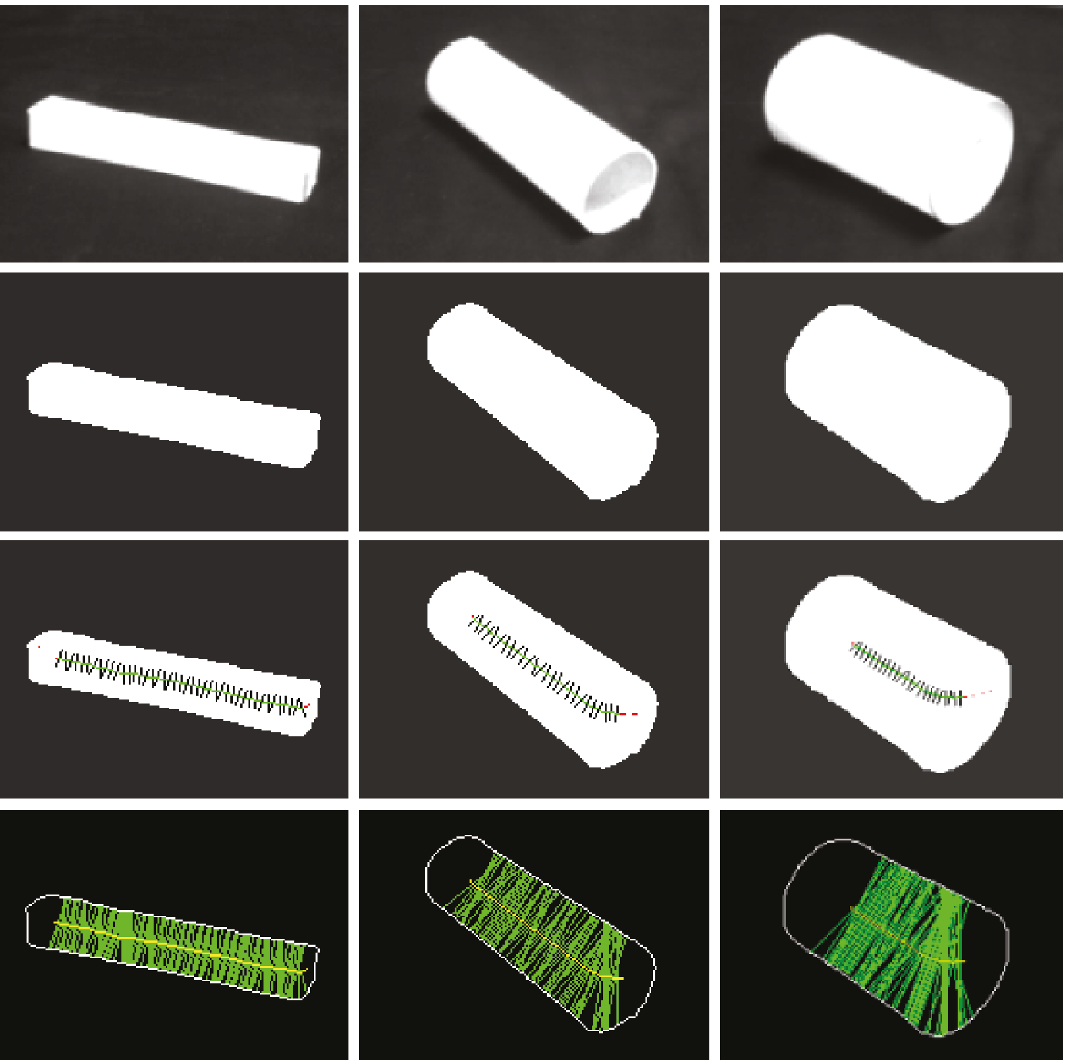
Figure 6: Detection test with simple images. The first row contains the original images. In the second row, the results of a segmentation stage are depicted. The third row contains the results of the curvilinear properties evaluation algorithm. The points of the skeletons inside the region of interest have been drawn; the green pixels represent the parts of the skeleton with a positive evaluation in the curvilinear properties, and the red ones those parts with a negative evaluation. Also, the estimated normal vectors to the skeleton points have been drawn in black. Finally, in the fourth raw, the skeletons of the detected curvilinear regions are depicted in yellow, and in green the normal vectors that have been prolonged to see the crosspoints with the